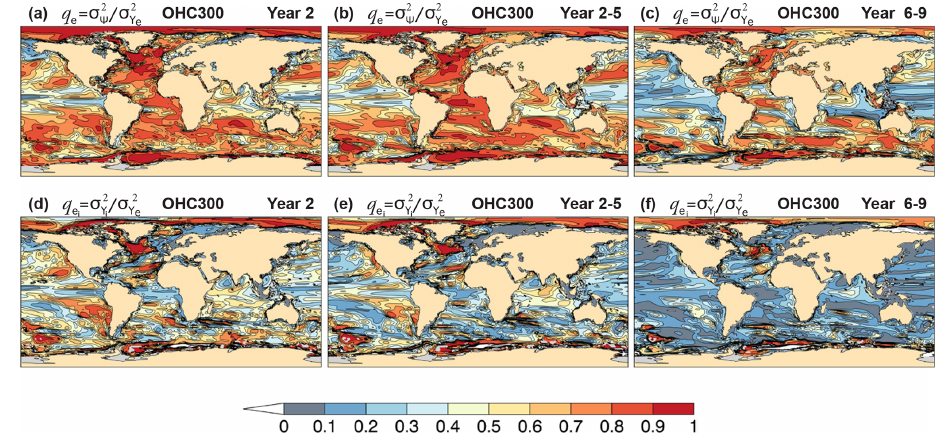
Figure 1. Potential predictability of CanESM5 hindcasts of annual and multi-year mean heat content above 300m. (a–c) Potentially pre- dictable variance fraction q e = σ 2 (b, e) Year 2–5, and (c, f) Year 6–9.